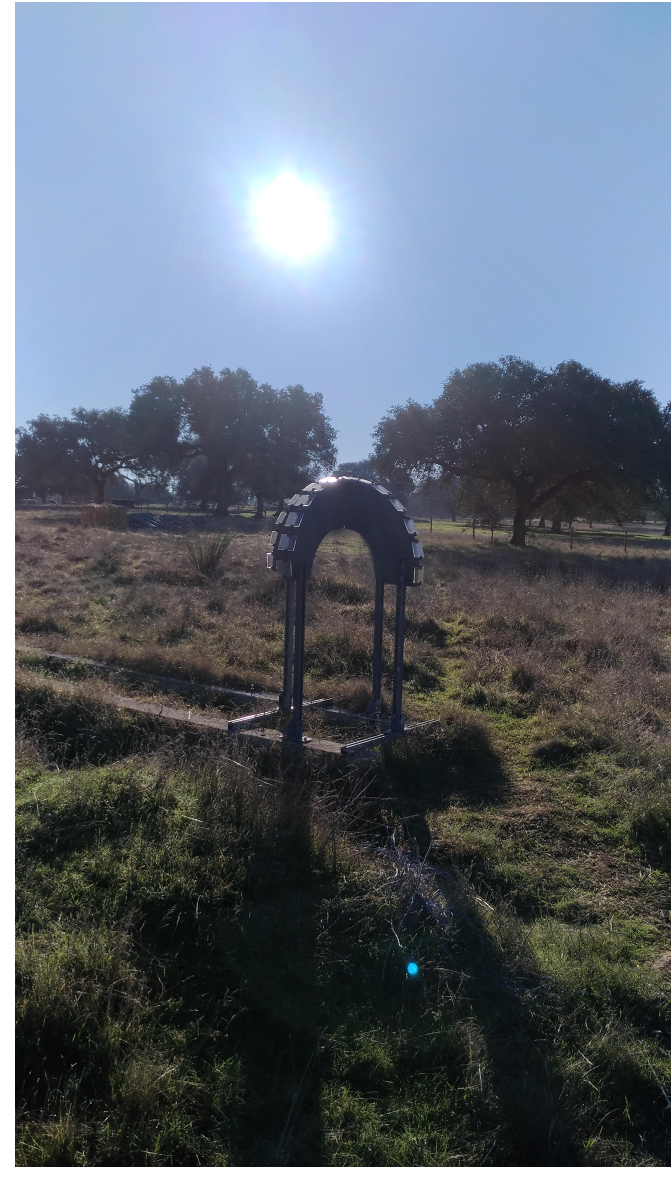
Figure 1. Glass tree apparatus in Solar Colector Test Plataform